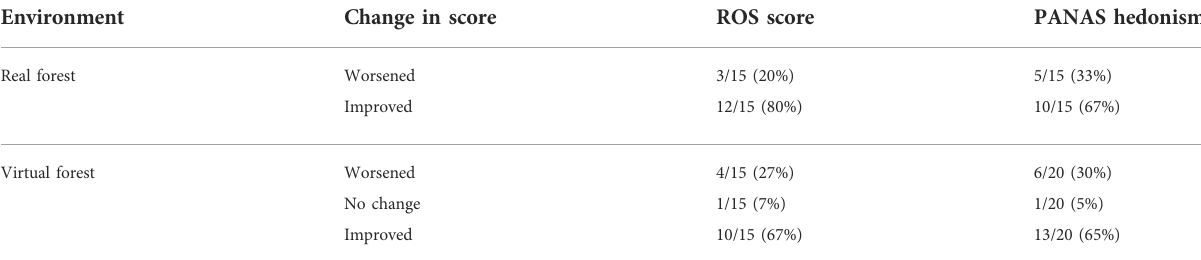
TABLE 3 Binary improvement from before the session to after forest bathing. Classifying participants as either bene fi ting from the experience or worsening. Environment Real